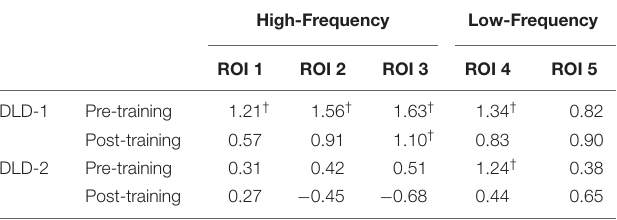
TABLE 3 | Pre-training and post-training HbO 2 z -scores for high- and low-frequency for DLD-1 and DLD-2.